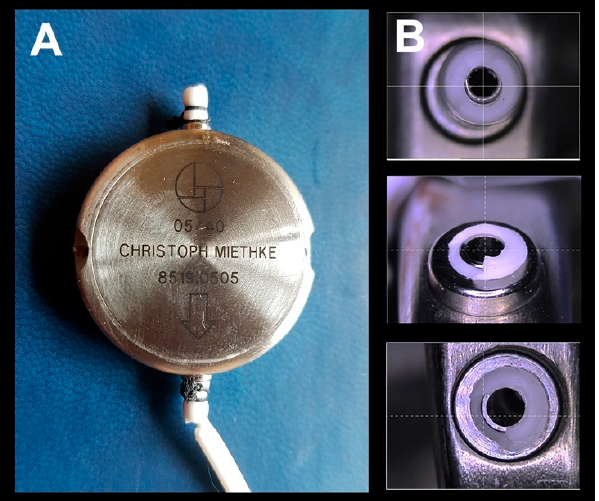
Figure 5. Images of Miethke ® Dual-Switch valves (M-DSV) explanted after diagnosing a fracture of the distal catheter of the valve. Fractures typically occur at the connector tip level of first ( A ) or second ( B ) generation M-DSV. Note that at the distal end of the valve, there is a catheter fragment sutured to the connector, indicating that a fracture of the catheter at the distal end of the connector had occurred and not a disconnection of the catheter due to failure of the suture.